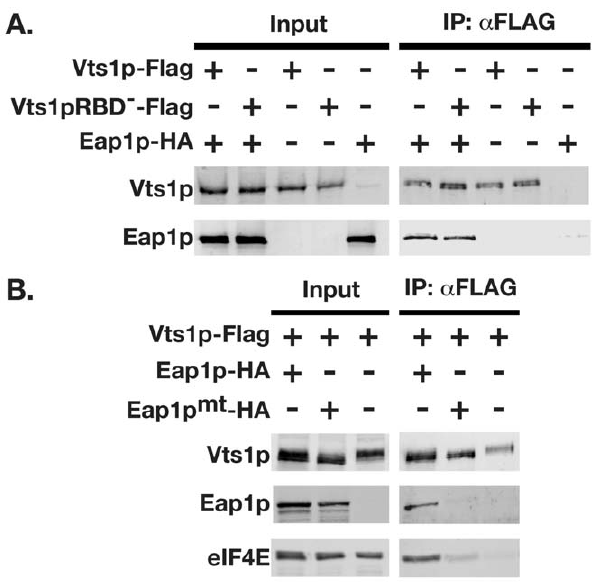
Figure 6. Eap1p mediates an indirect interaction between Vts1p and eIF4E. Vts1p-Flag and Eap1p-HA were expressed in yeast cells individually or in combination as indicated in either vts1 D cells ( A ) or eap1 D cells ( B ) and crude extracts were subjected to immunopre- cipitation using an anti-Flag resin. Starting crude extracts (input) and the resulting immunoprecipitates (IP: a FLAG) were analyzed by Western blot. Input samples represent 5% for Vts1p blots, 2% for Eap1p blots and 1% for eIF4E of material used in the immunoprecipitations. The use of the Vts1p RNA binding mutant (Vts1pRBD 2 ) and Eap1p mutant defective for eIF4E binding (Eap1p mt ) are as